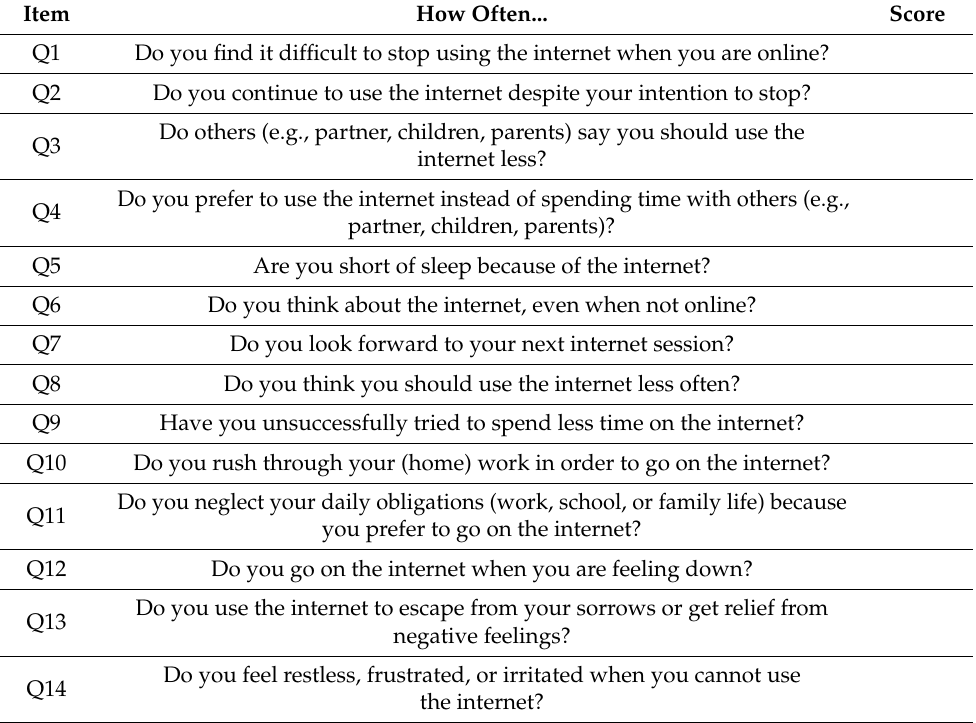
Table A2. Compulsive internet use scale